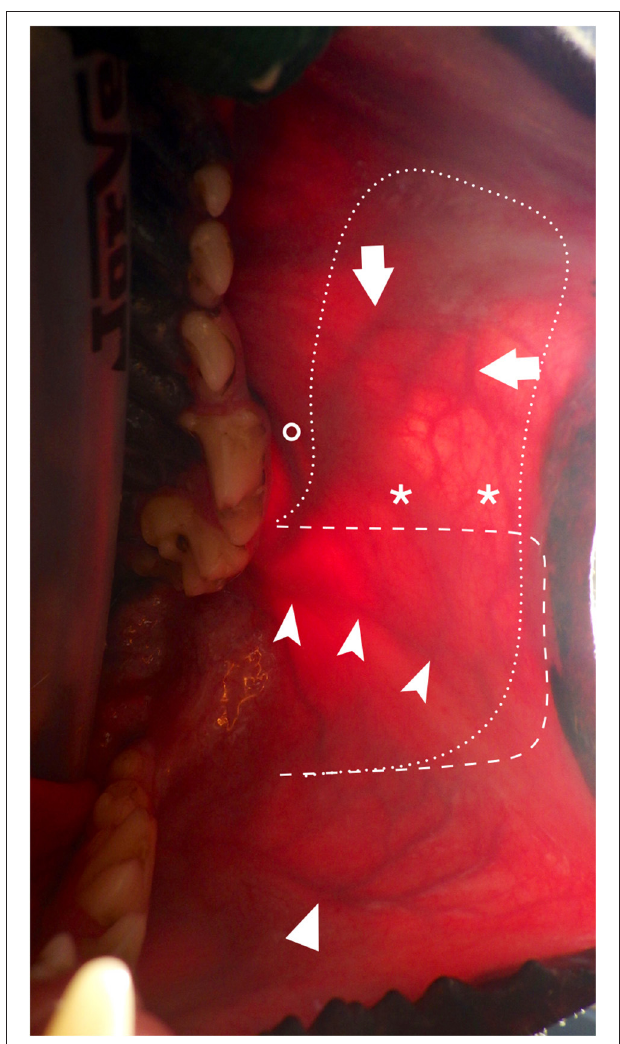
FIGURE 4 | Transillumination intraoral view of the main arteries of the cheek and lips and surgical outline. (arrow: SLA; chevron arrowhead: AOA; simple arrowhead: ILA; asterisks: anatomoses between SLA and AOA; interrupted dash line: limits depicting the facial artery myomucosal (FAMM) flap centered on the AOA; interrupted dot line: limits depicting the facial artery myomucosal (FAMM) flap incorporating the AOA and SLA; circle: parotid duct papilla. AOA, angularis oris artery; SLA, superior labial artery; ILA: inferior labial